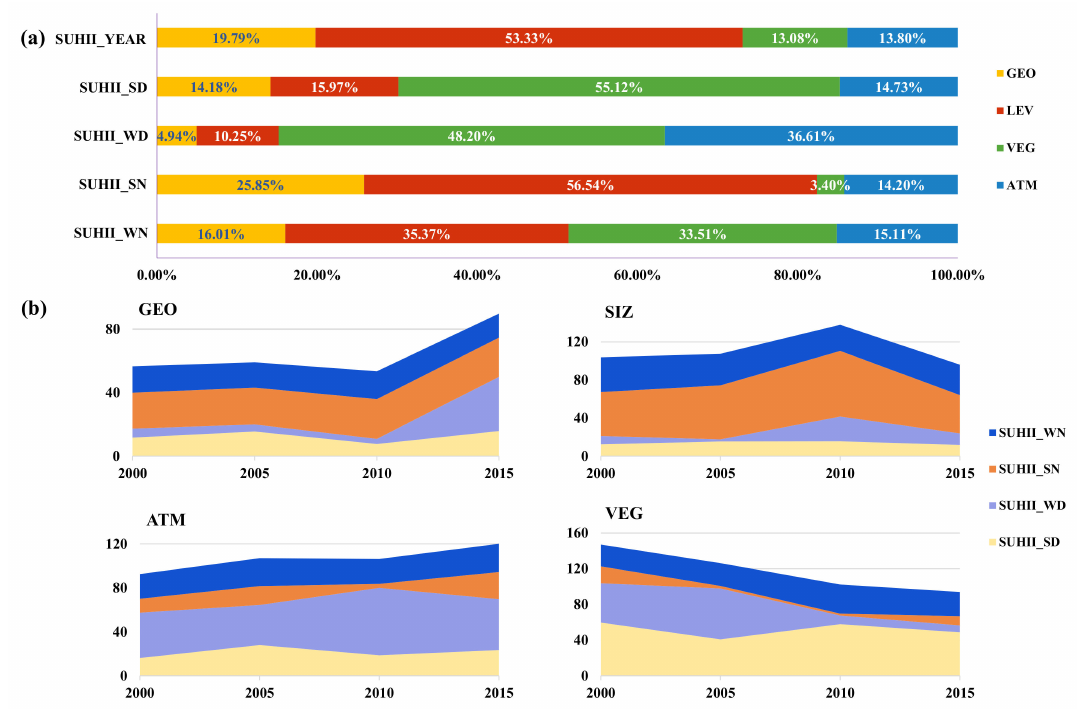
Figure 7. The contribution rates for the three categories of the urban form and atmospheric factors (ATM) ( a ) and their change trends from 2000 to 2015 ( b